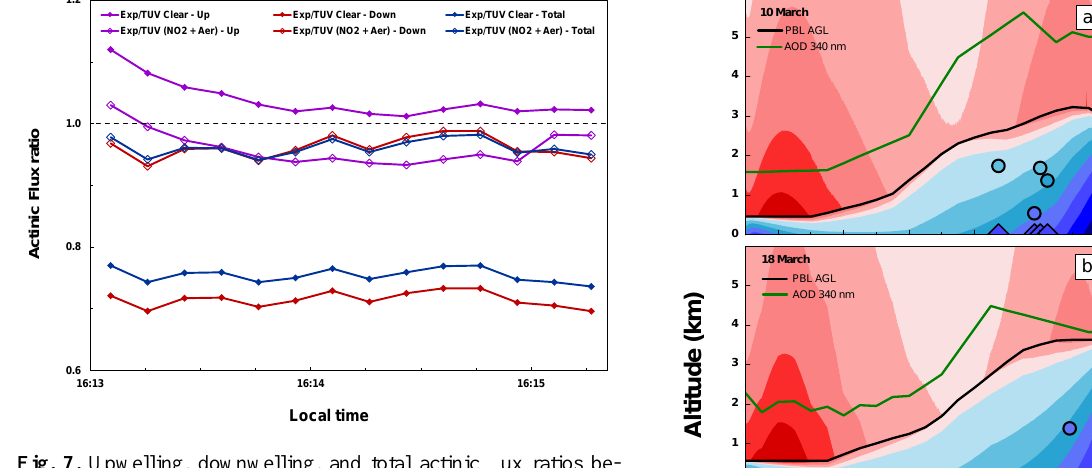
Fig. 7. Upwelling, downwelling, and total actinic flux ratios be- tween the aircraft measurements and model calculations (clear sky and polluted) for 10 March. During this period aircraft altitude was 1.4km (a.g.l.) and PBL altitude 3km (a.g.l.). Dashed horizontal line corresponds to measurement/model ratio equal to 1.